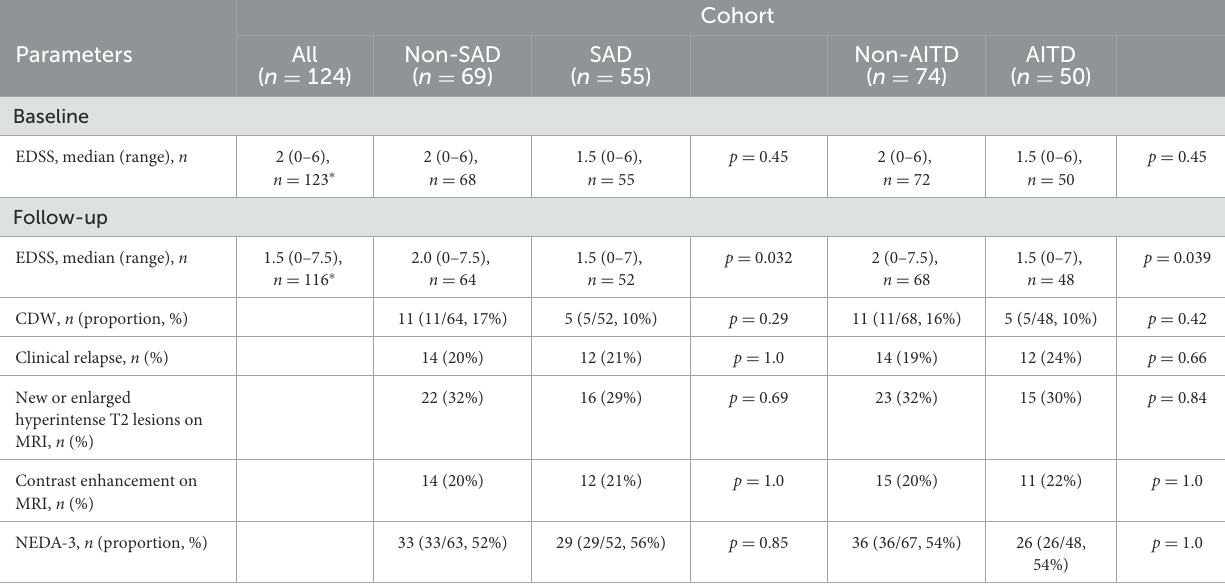
TABLE 4 Influence of SAD and AITD on clinical activity, MRI, and disability, at the baseline and follow-up [median 4.5 y (ranging from 1.3 to 11.2)].